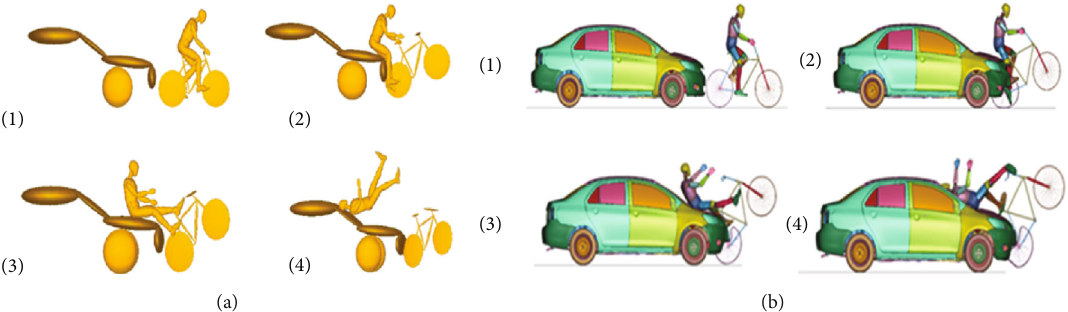
Figure 14: Cyclist ’ s kinematics during an overtaking crash. (a) MADYMO run-over simulation; (b) FEM